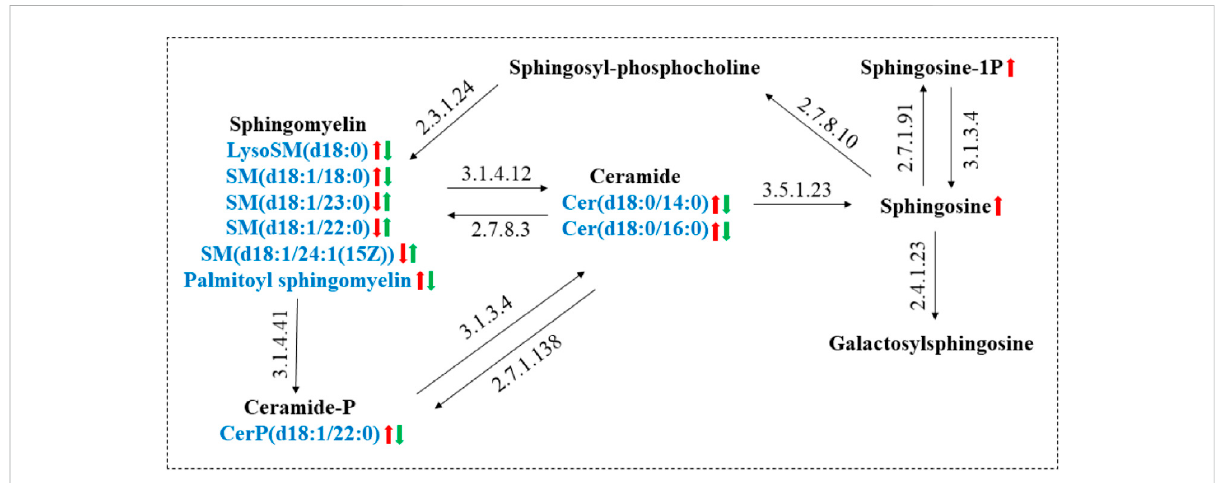
FIGURE 8 Metabolic networks of major sphingolipid metabolism markers associated with RA and the role of GE intervention. (Red arrows: trends in RA- induced changes in sphingolipid metabolites; Green arrows: trends in sphingolipid metabolites associated with GE treatment).